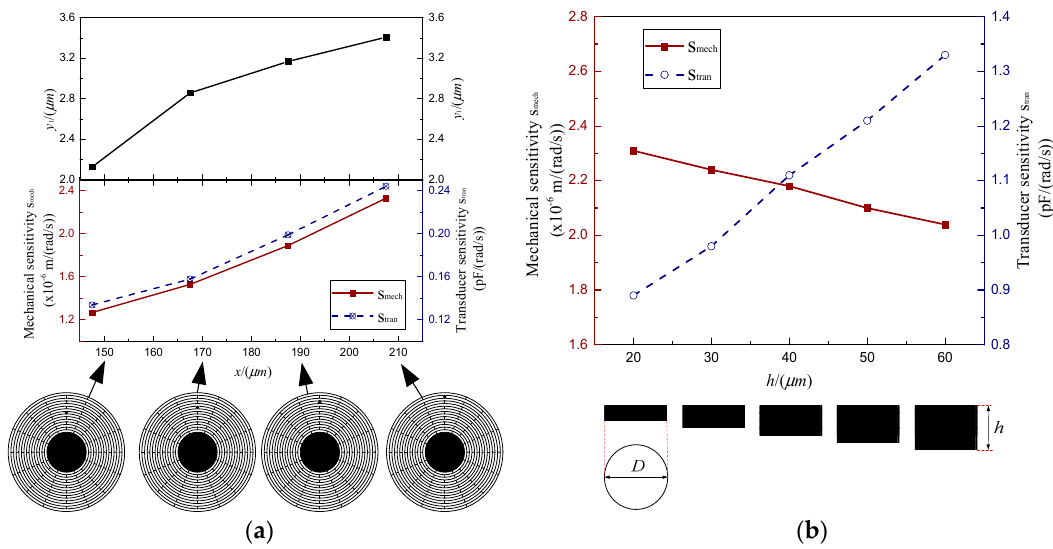
Figure 14. ( a ) The y 1 , mechanical sensitivities and the transducer sensitivities with different ring numbers ( b ) The mechanical sensitivities and the transducer sensitivities with the height of the MOEMS-RG.